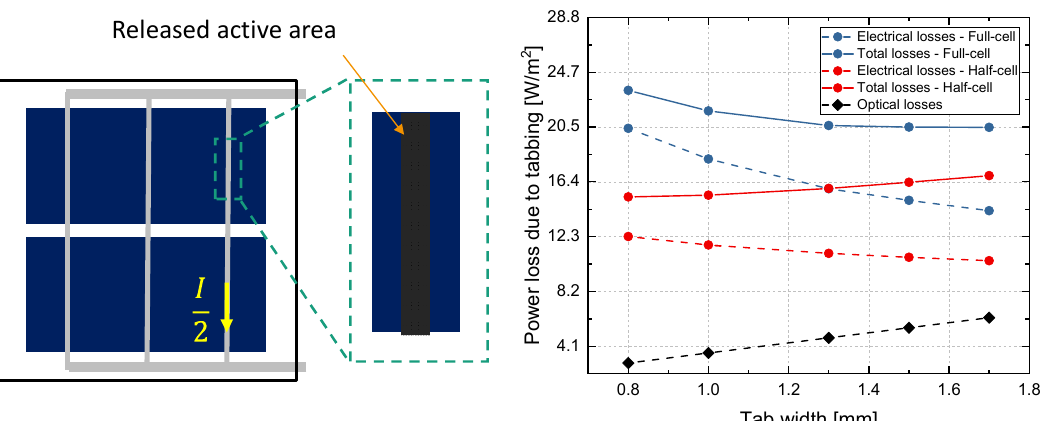
Figure 6. ( left ) Schematic view of the half-cell module made from cells with M2-size wafers and a magnification on tab section which shows the reduced tab size and related released active area, which was shaded below the tab; and ( right ) simulated electrical, optical and overall power loss densities related to the total active width covered by tab on the solar cells. The optimum tab width might vary according to the number of busbars and electrical characteristics of the solar cells.